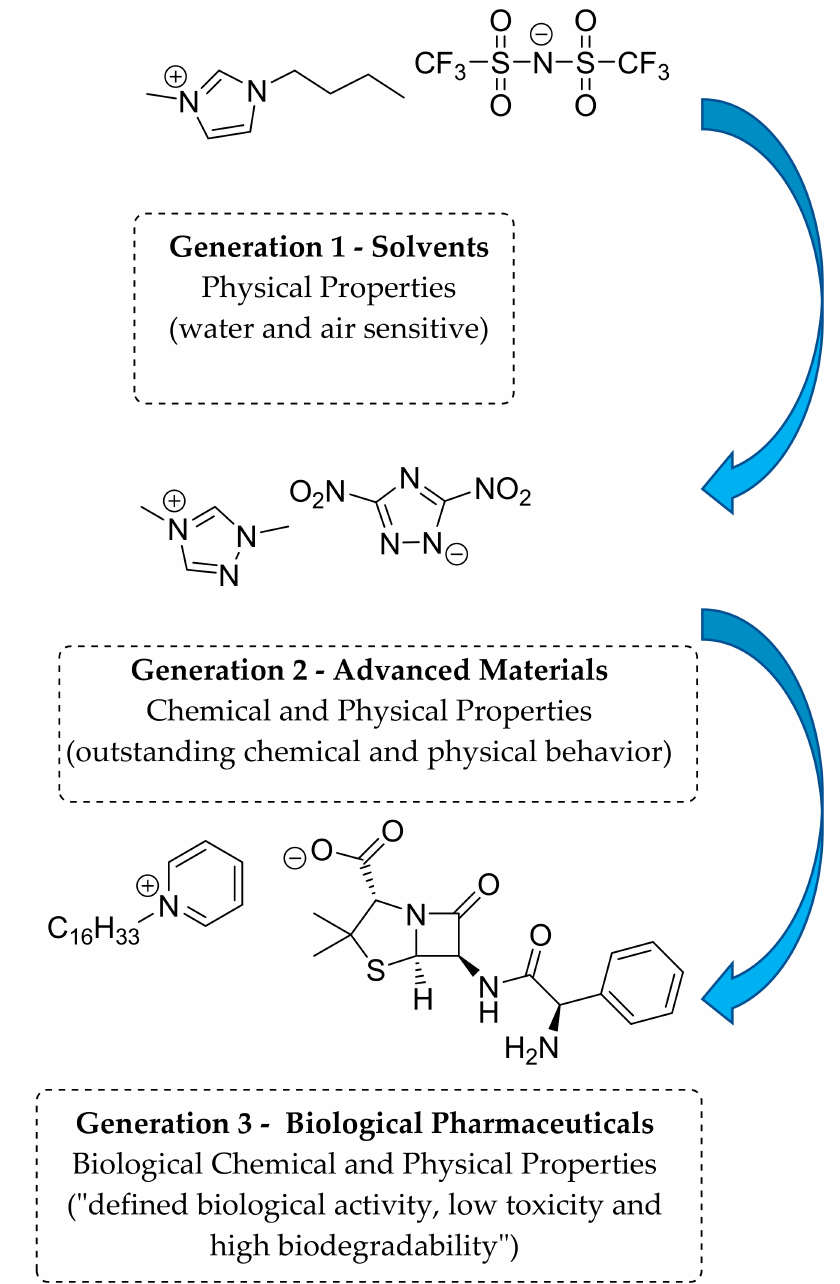
Figure 1. The three generations of ionic liquids (ILs) and their evolution adapted from Ferraz et al.